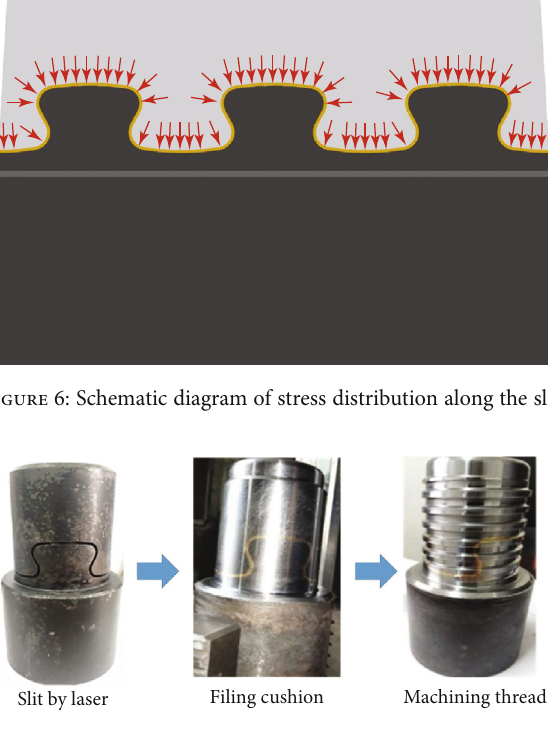
Figure 7: Processing fl ow of the bionic drill pipe